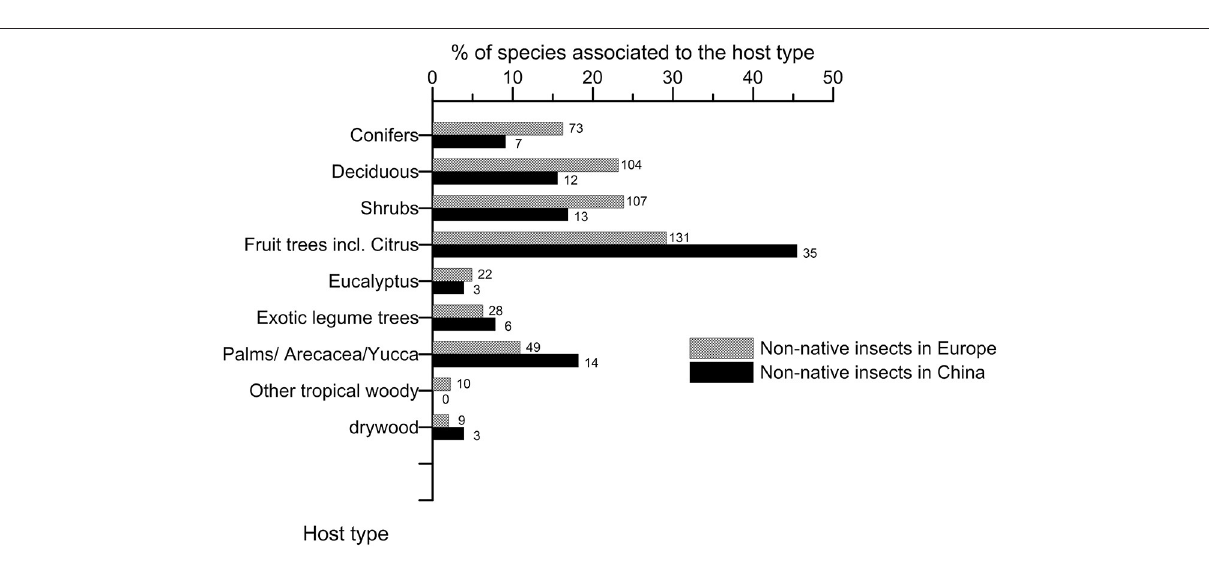
China, citing the example ofa drywood termite (